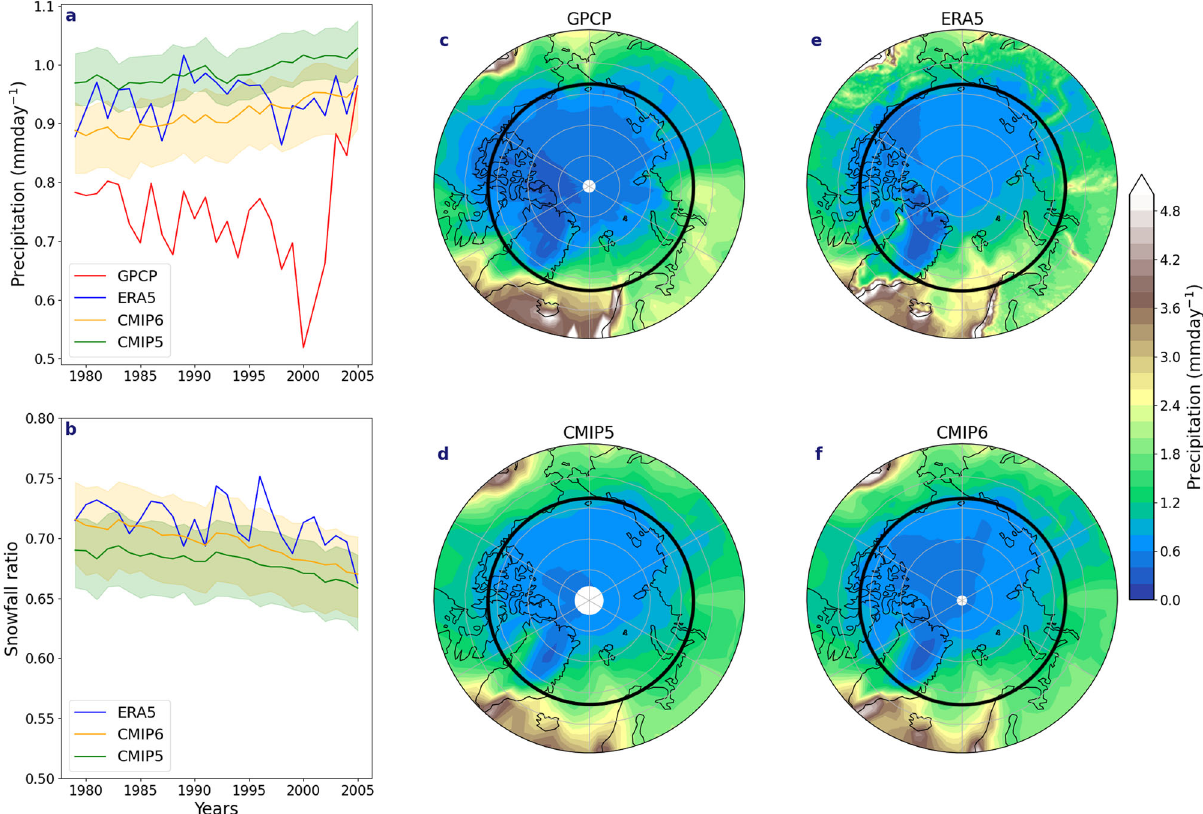
Fig. 1 Time series of precipitation, and snowfall ratio and spatial climatology of total precipitation. a Annual precipitation means over the Arctic (70°N – 90°N) from 1979 to 2005, covering the satellite era and the start of the GPCP record concluding with the end of the historical period for GPCP, ERA5, CMIP5 and CMIP6. b Annual snowfall ratio (snowfall/total precipitation) over the Arctic for the same observational record of 1979 – 2005 for ERA5, CMIP6 and CMIP5. The shading in both represents the 5th to 95th percentile spread in the models. Climatological precipitation for the same record over the Arctic for c GPCP, d CMIP5, e ERA5 and f CMIP6. The Arctic region for all time series analyses is taken as the area poleward of 70°N, shown as the dark circle in c – f